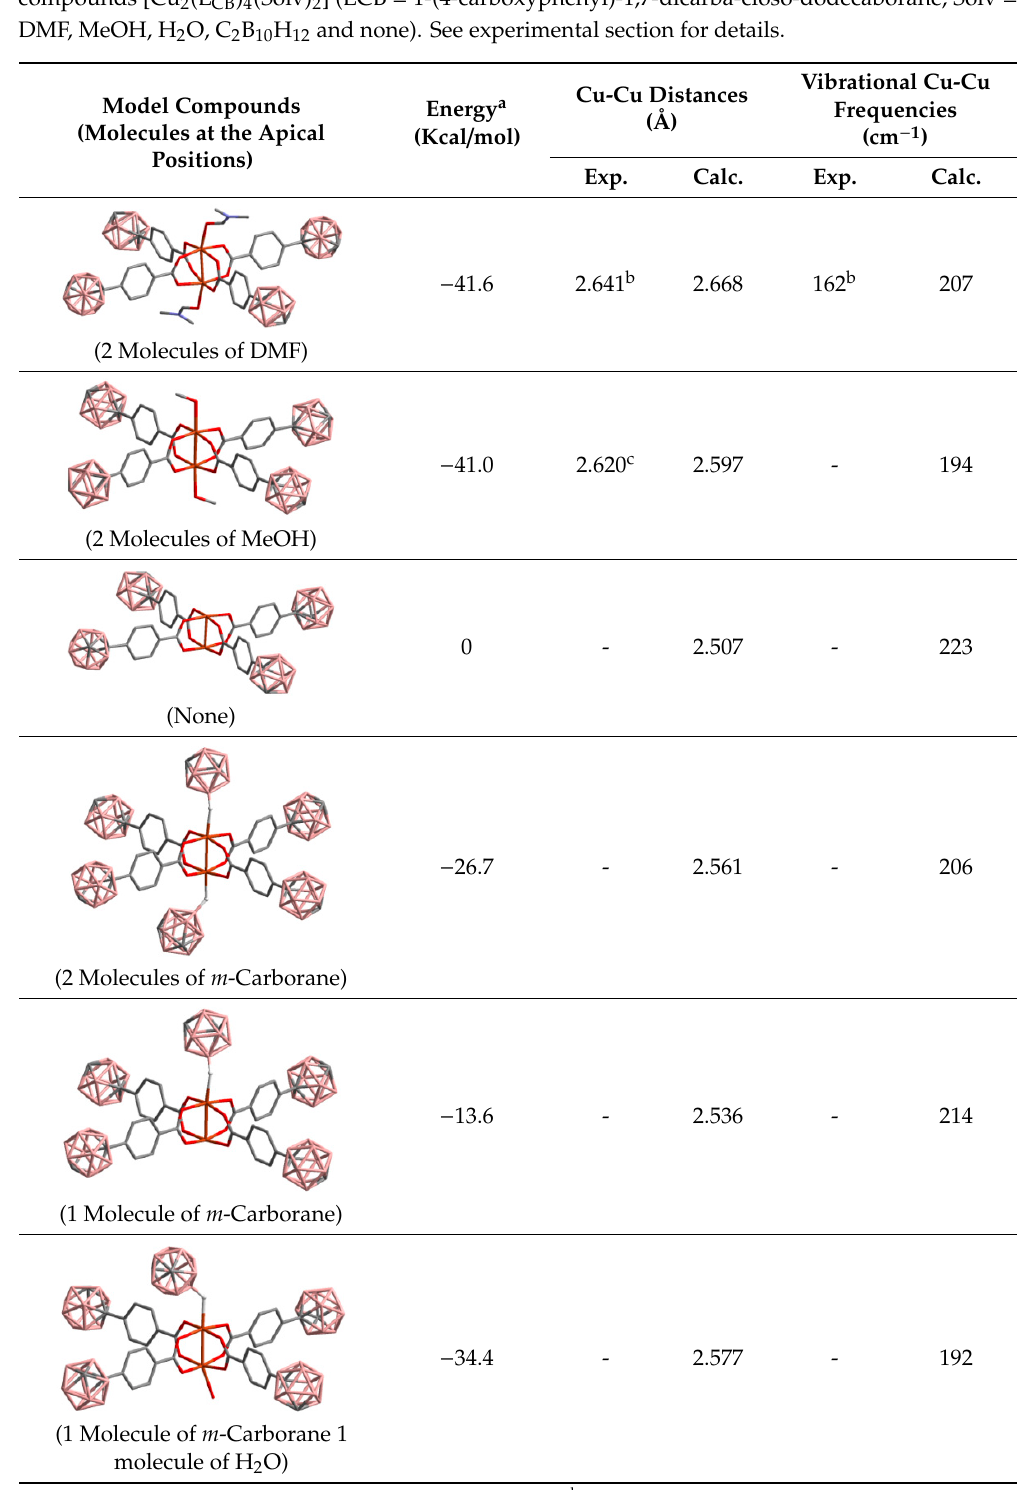
Table 2. Calculated Energies, Cu-Cu Bond Lengths and vibrational frequencies for the Model